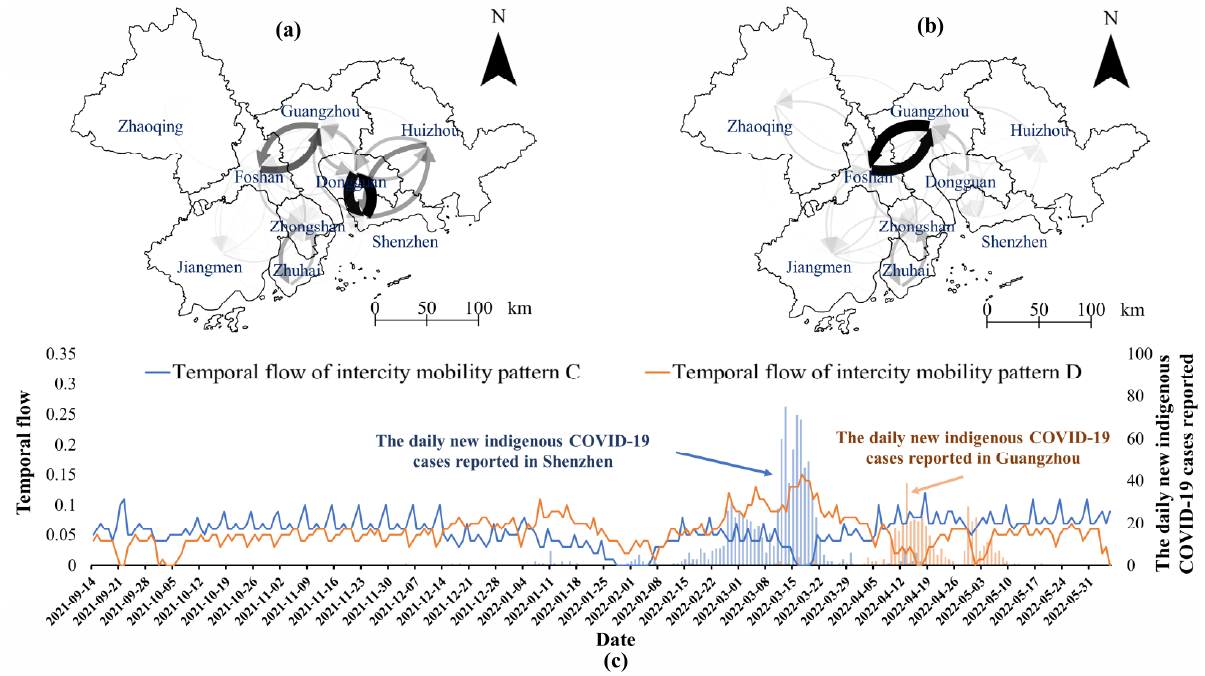
Figure 7. The intercity daily mobility patterns in the GBA. ( a ) Spatial flow in intercity mobility pattern C. ( b ) Spatial flow in intercity mobility pattern D. ( c ) Temporal flow in intercity mobility patterns C and D. The blue bar and orange bar denotes the daily new indigenous COVID-19 cases reported in Shenzhen and Guangzhou,